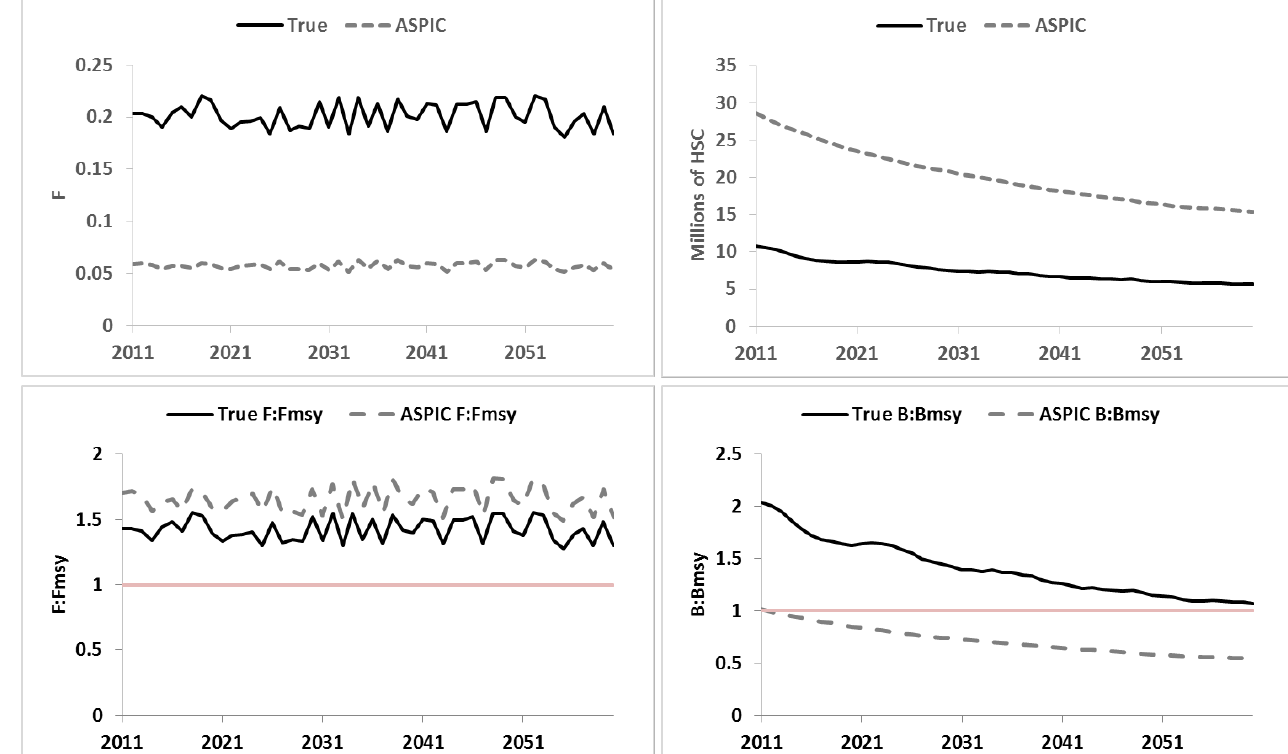
Figure 91. Comparison between simulated “true” data from the operating model and surplus production (ASPIC) results for simulation